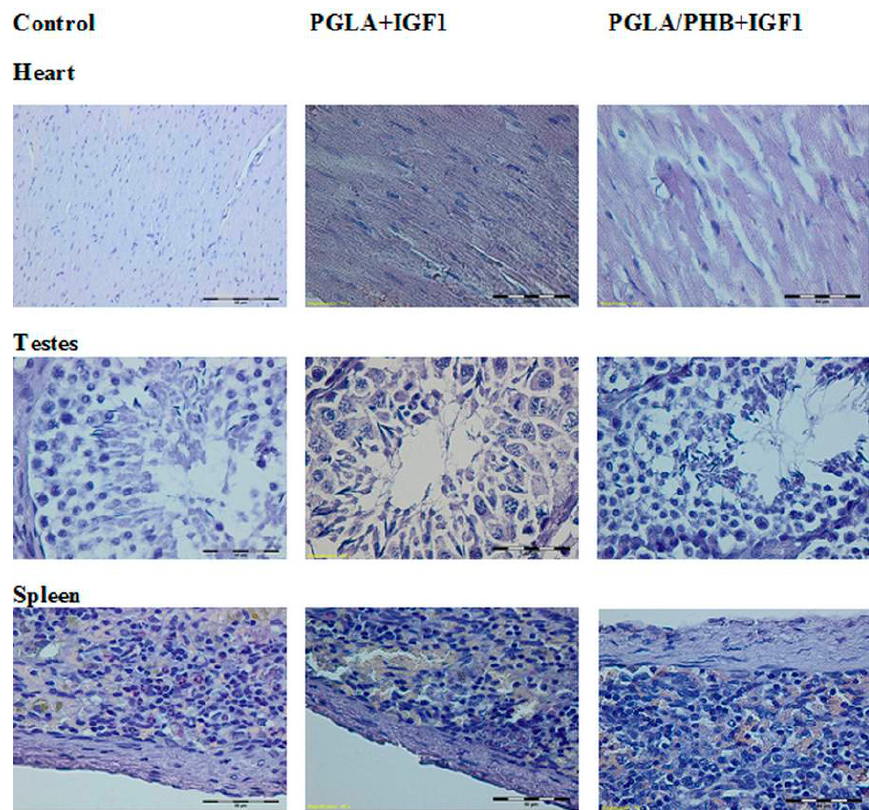
Figure 18. Microscopic images of internal organs. (Dye HE. MG100×).